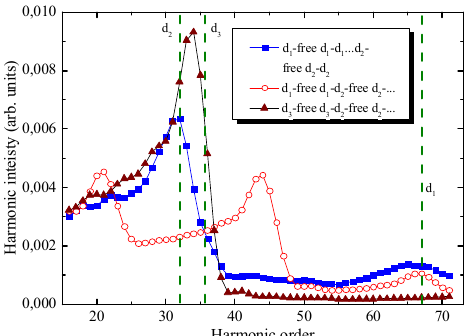
Figure 7. Harmonic distribution in the case of propagation of two-color pulses (1310 nm + 655 nm) through silver MJP of 5 mm length consisting of different combinations of two groups of jets (see text).